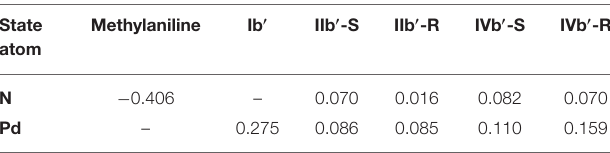
TABLE 2 | The ADCH charge of the N and the Pd in different states for Pd-L ′ catalytic system. State atom